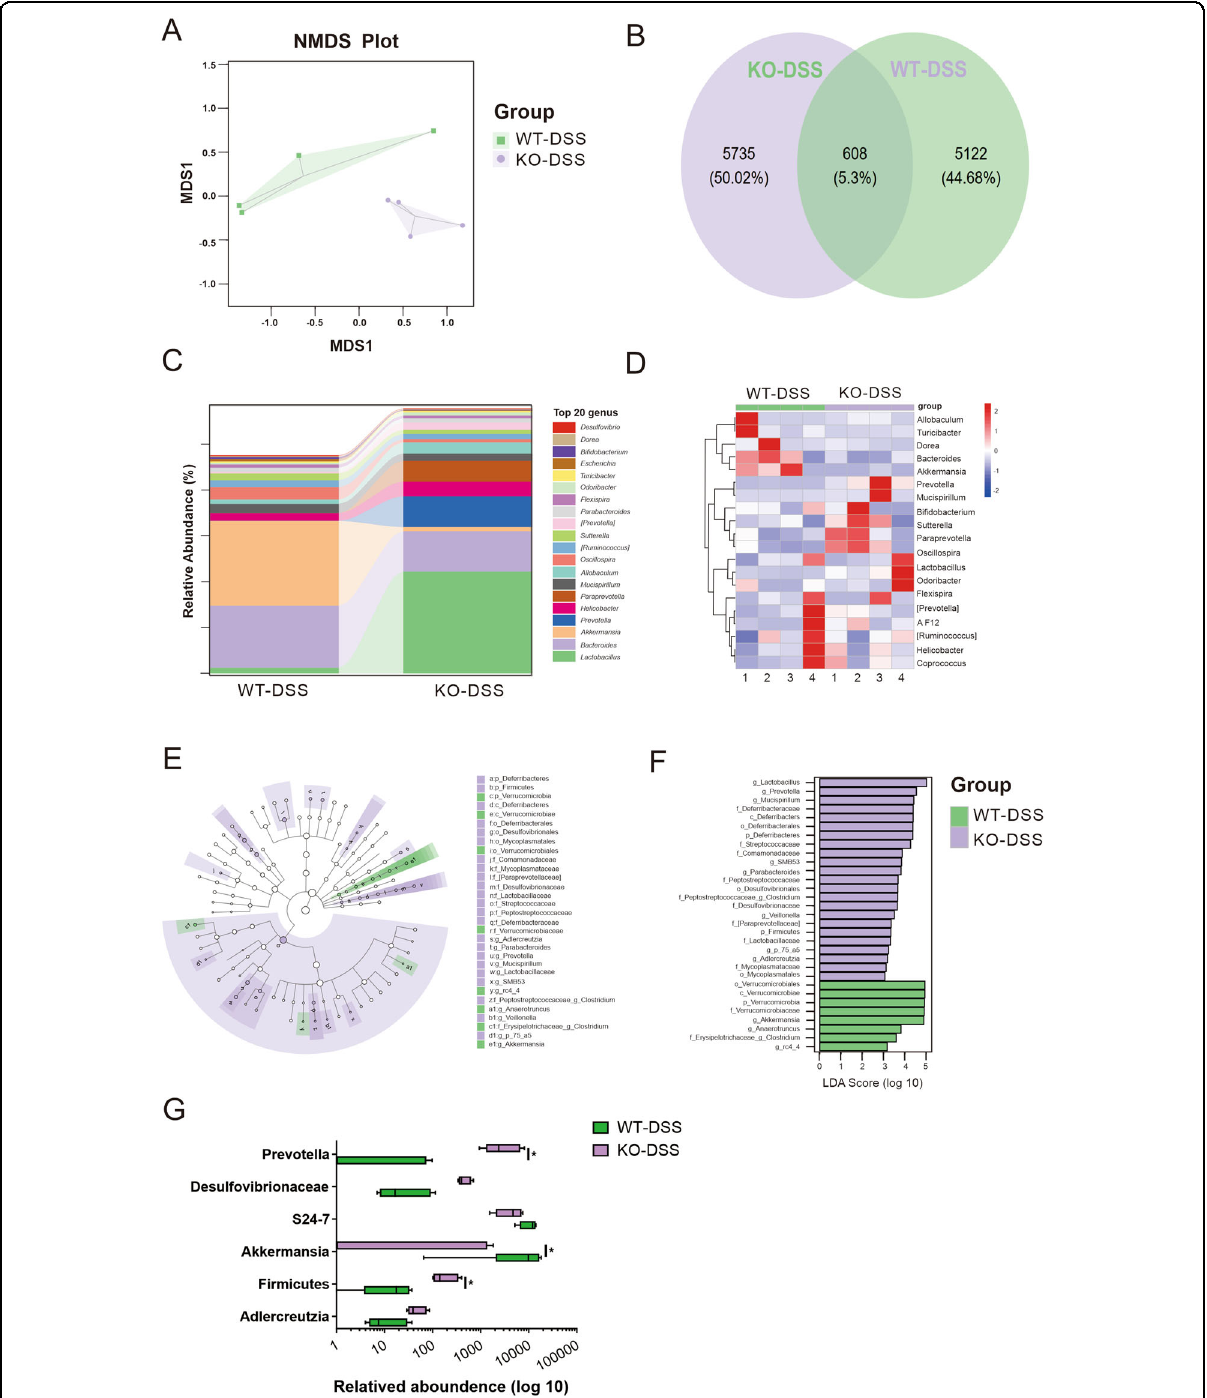
Fig. 7 Altered compositional patterns of microbiota in KO-DSS mice. A Nonmetric multidimensional scaling analysis on OTUs ( n = 4/group). Each sample represents a single sample (from one mouse) and is colored according to group. B The Venn diagram shows that OTUs were overlapped in each group. C Histogram of genus horizontal species composition between the two groups. D The heat map of genus level species composition shows abundance of the top 20 bacterial taxa. The red block indicates that the genus has a higher abundance in the sample than other samples, while the blue block indicates that the genus has a lower abundance in the sample than other samples. E Bar chart of LDA effect values of identi fi ed species. F Display diagram of inter-group difference taxon based on classi fi cation rank tree. G Relative abundance of each group. Statistical analyses were performed with A the Permanova test, or G the Mann – Whitney U test. NMDS, nonmetric multidimensional